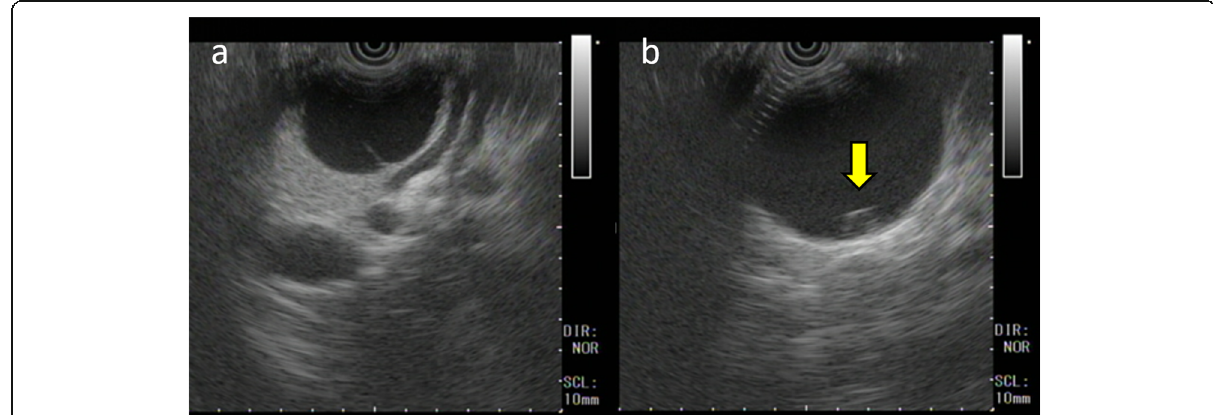
Fig. 3 Endoscopic ultrasound revealed a multilocular cystic tumor ( a ) with nodular lesion ( b , arrow).